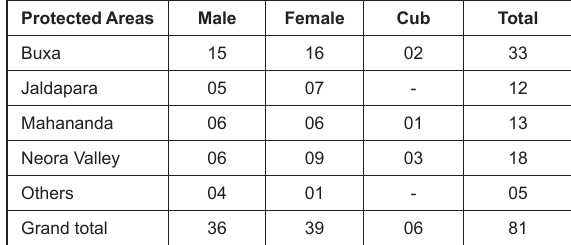
Table 3. Population composition of tiger in northern West Bengal during – 1999 (Thapliyal 2001)